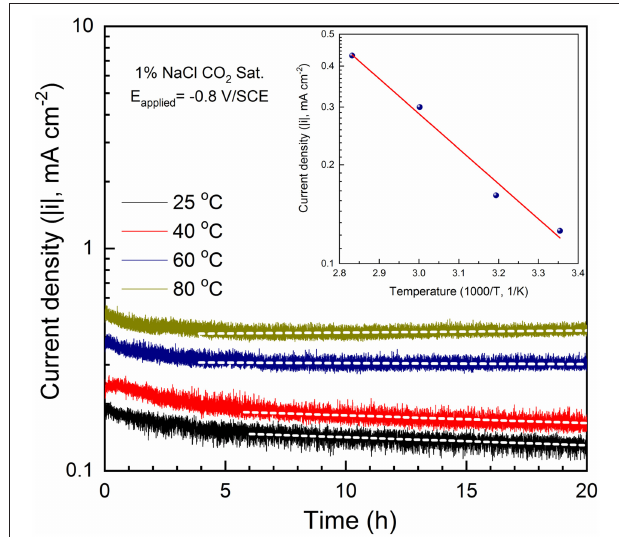
FIGURE 13 | Potentiostatic polarization curves (E applied = − 0.8 V/SCE) of C1010 steel tested in 1% NaCl with CO 2 saturation at different temperature levels, i.e., 25, 40, 60, and 80 ◦ C. Inset: a plot of i as a function of 1/T for the calculation of cathodic activation energy of 20 kJ mol − 1 .